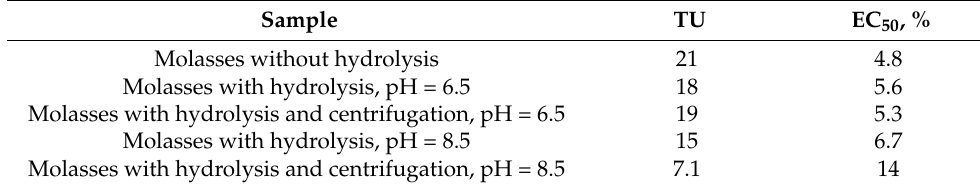
Table 3. Toxicity of molasses samples analyzed (Microtox